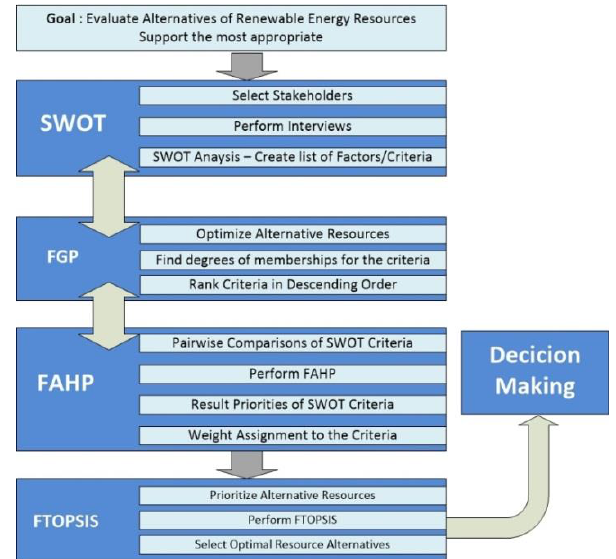
Figure 4. Methodological map in evaluating renewable energies.